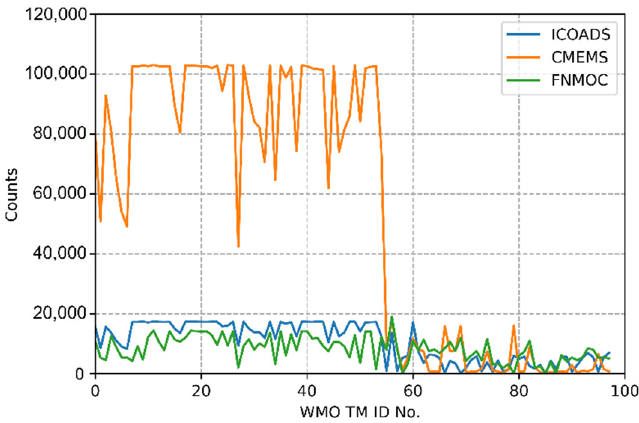
Figure 8. NOBS from 98 UIDs shared by ICOADS, CMEMS, and Figure 8 . NOBS from 98 UIDs shared by ICOADS, CMEMS, and FNMOC.